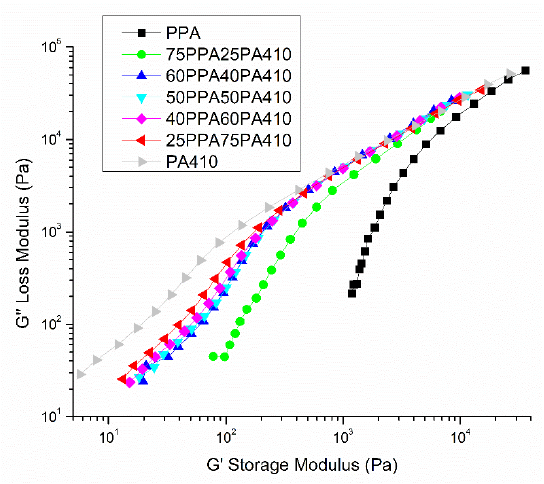
Figure 9. Cole–Cole plot of neat polymers and prepared